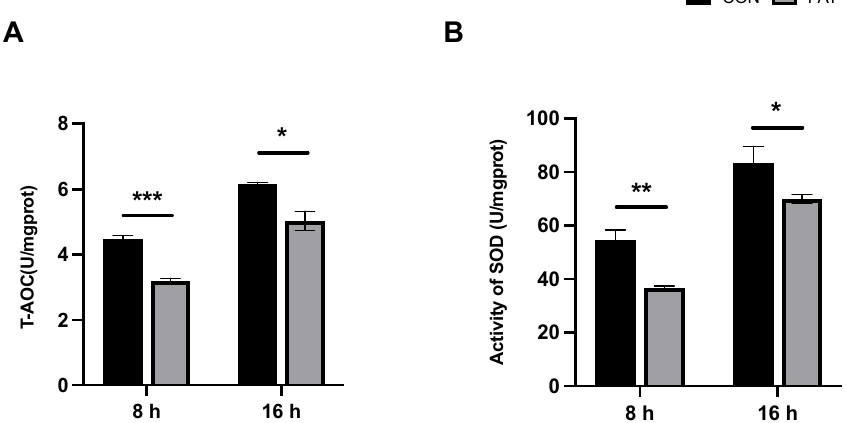
Figure 2. Total intracellular antioxidant capacity (T − AOC) ( A ) and superoxide dismutase (SOD) activity ( B ) of L. plantarum CCFM1287 exposed to different reaction times. (* p < 0.05, ** p < 0.01, *** p < 0.001 vs. control group).